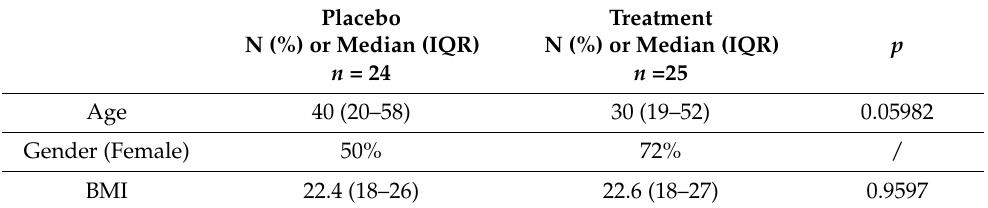
Table 2. Demographics in study cohort in IBS and placebo arms at V1 = baseline.